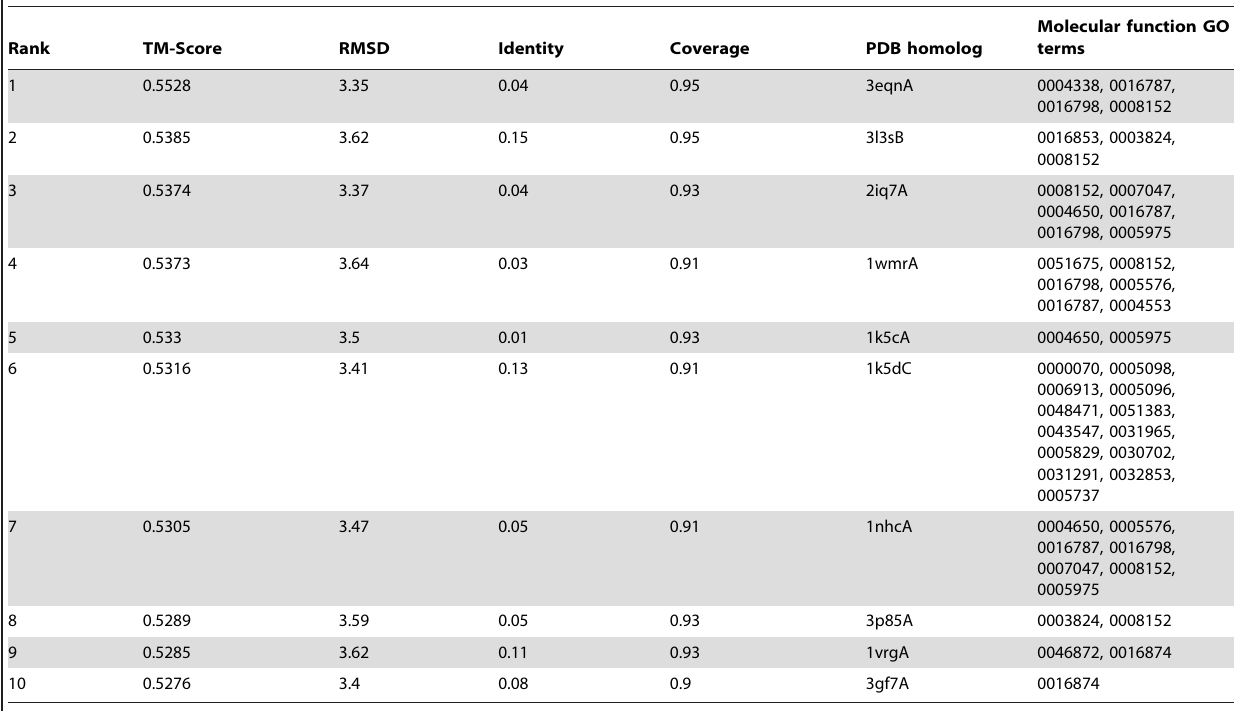
Table 3. Predicted molecular functions for the HEV PPR model.